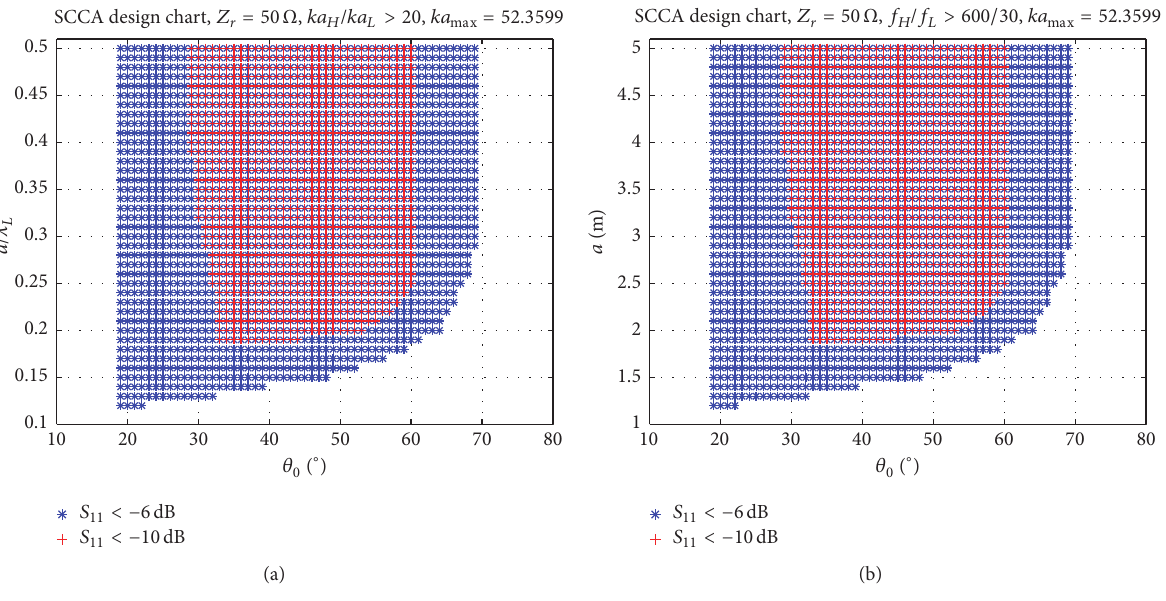
Figure 8: Design chart for the theoretical SCCA example with DF min = 20: (a) relative and (b) absolute length versus 𝜃 0 .